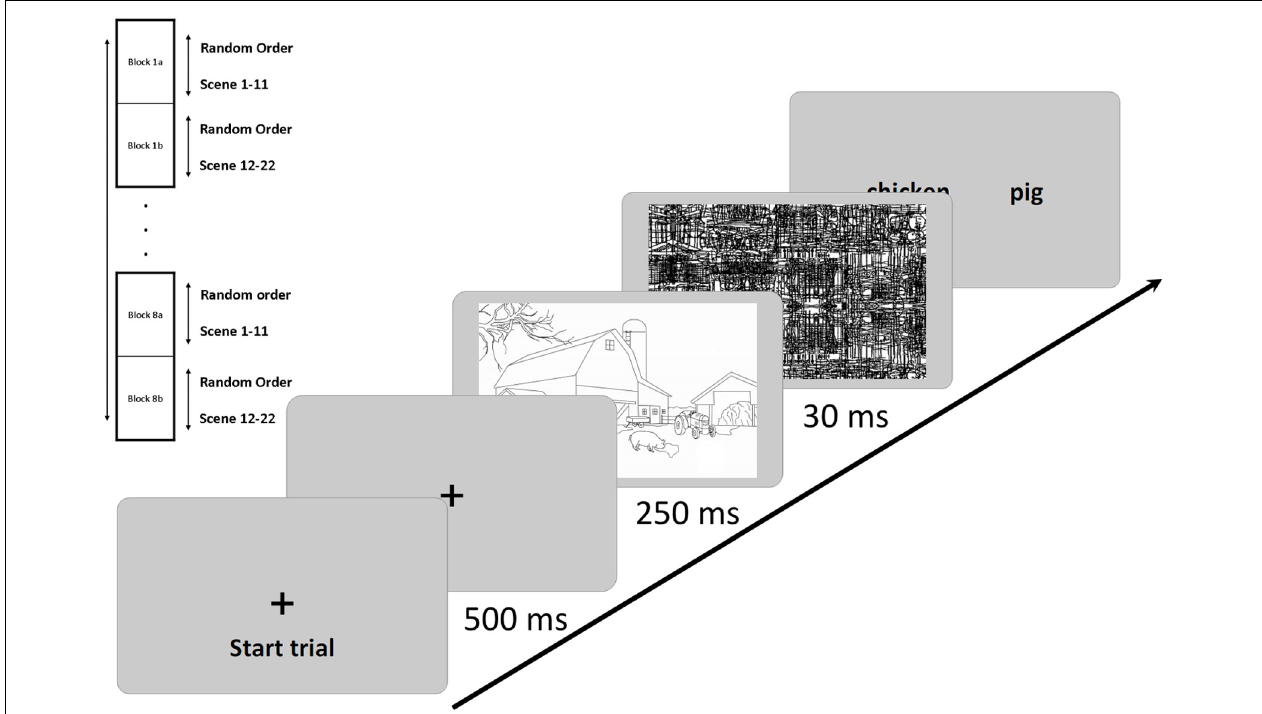
FIGURE 2 | Depicted is one trial of Experiments 1 and 2, and a scheme of how trials and blocks of trials were administered. Each of eight blocks (1–8) contained all scenes (or backgrounds) and was divided into two sub-blocks (e.g., 1a and 1b) of 11 different scene and object images each, to